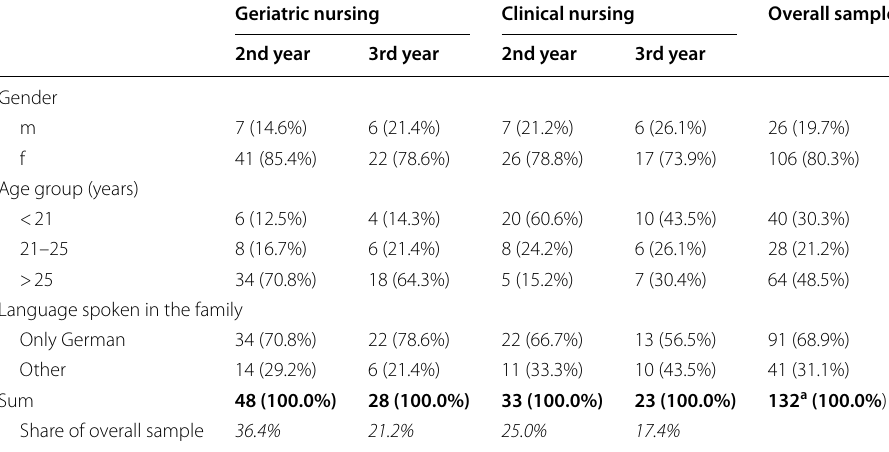
Table 3 Years of nursing education, gender, and age group for the geriatric nursing and the clinical nursing subsamples